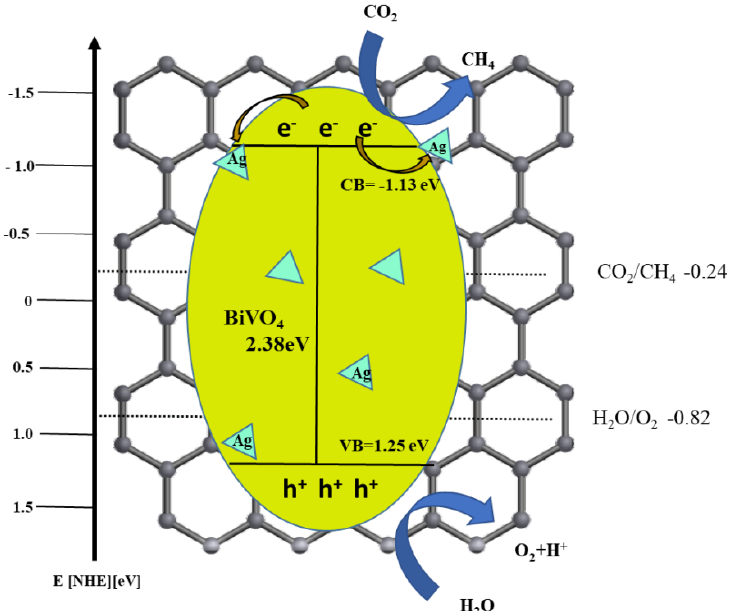
Figure 11. Proposed mechanism for CO 2 photoreduction over the as-obtained TAgNPt/Gra- phene/BiVO 4